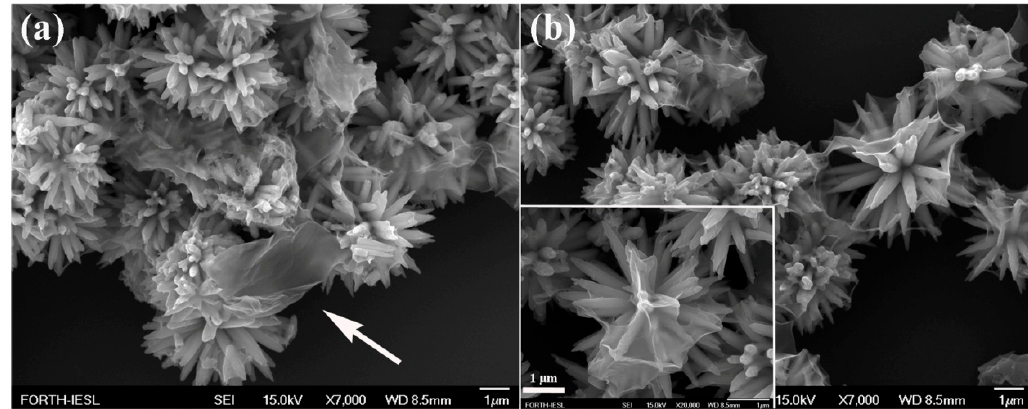
Figure 3. SEM images of rGO-modified ZnO–TiO 2 structures (ZT-rGO) structures at a 2 wt % reduced GO (rGO) loading without ( a ) and with ( b ) 3-aminopropyltrimethoxysilane (APTMS) functionalization.